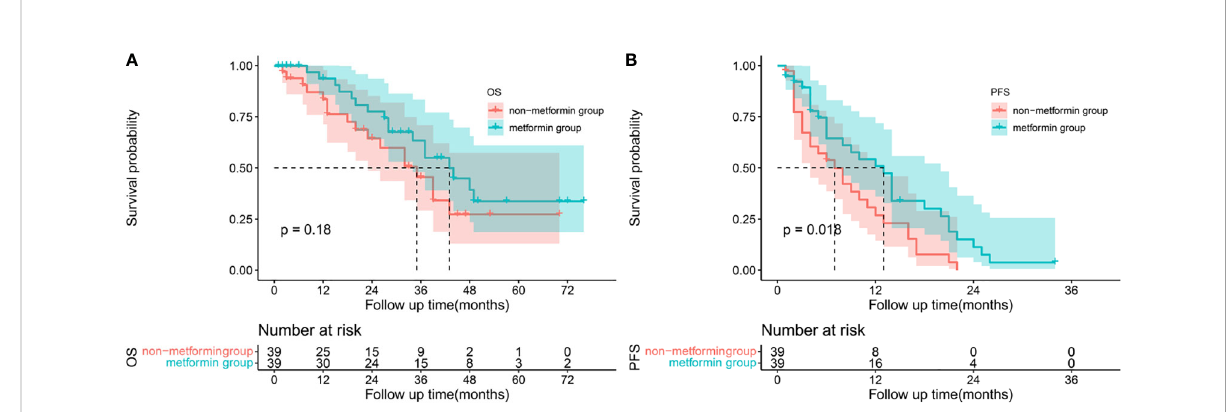
FIGURE 3 Survival analysis: Kaplan-Meier plots comparing metformin users versus non-metformin users among HCC patients with T2DM undergoing TACE. Overall survival (A) and progression-free survival (B) curves of matched